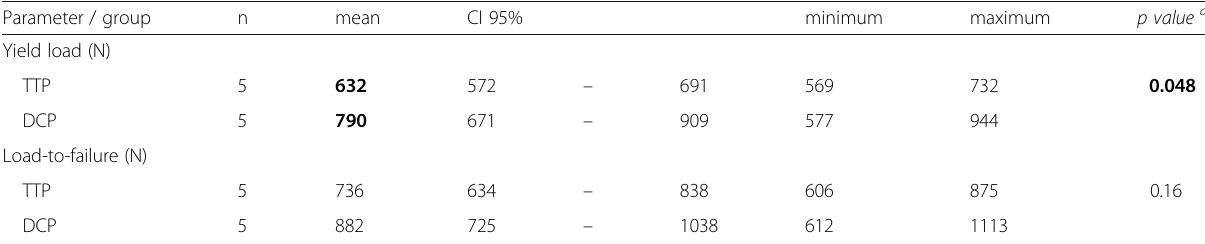
Table 2 Catastrophic failure (Stage 2 – TTP vs DCP group) Parameter /